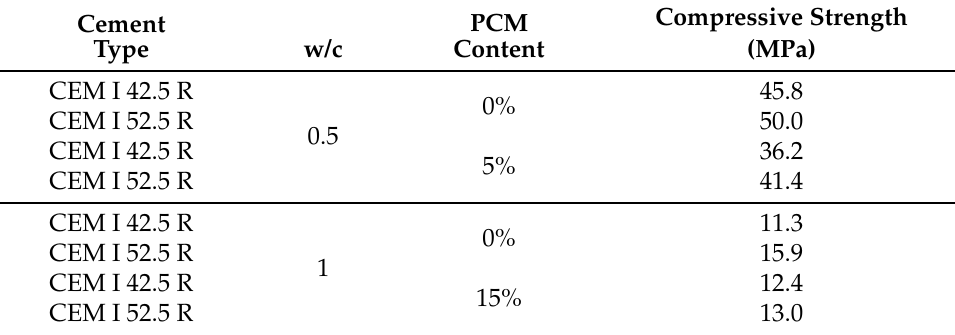
Table 10. Influence of PCM content on compressive